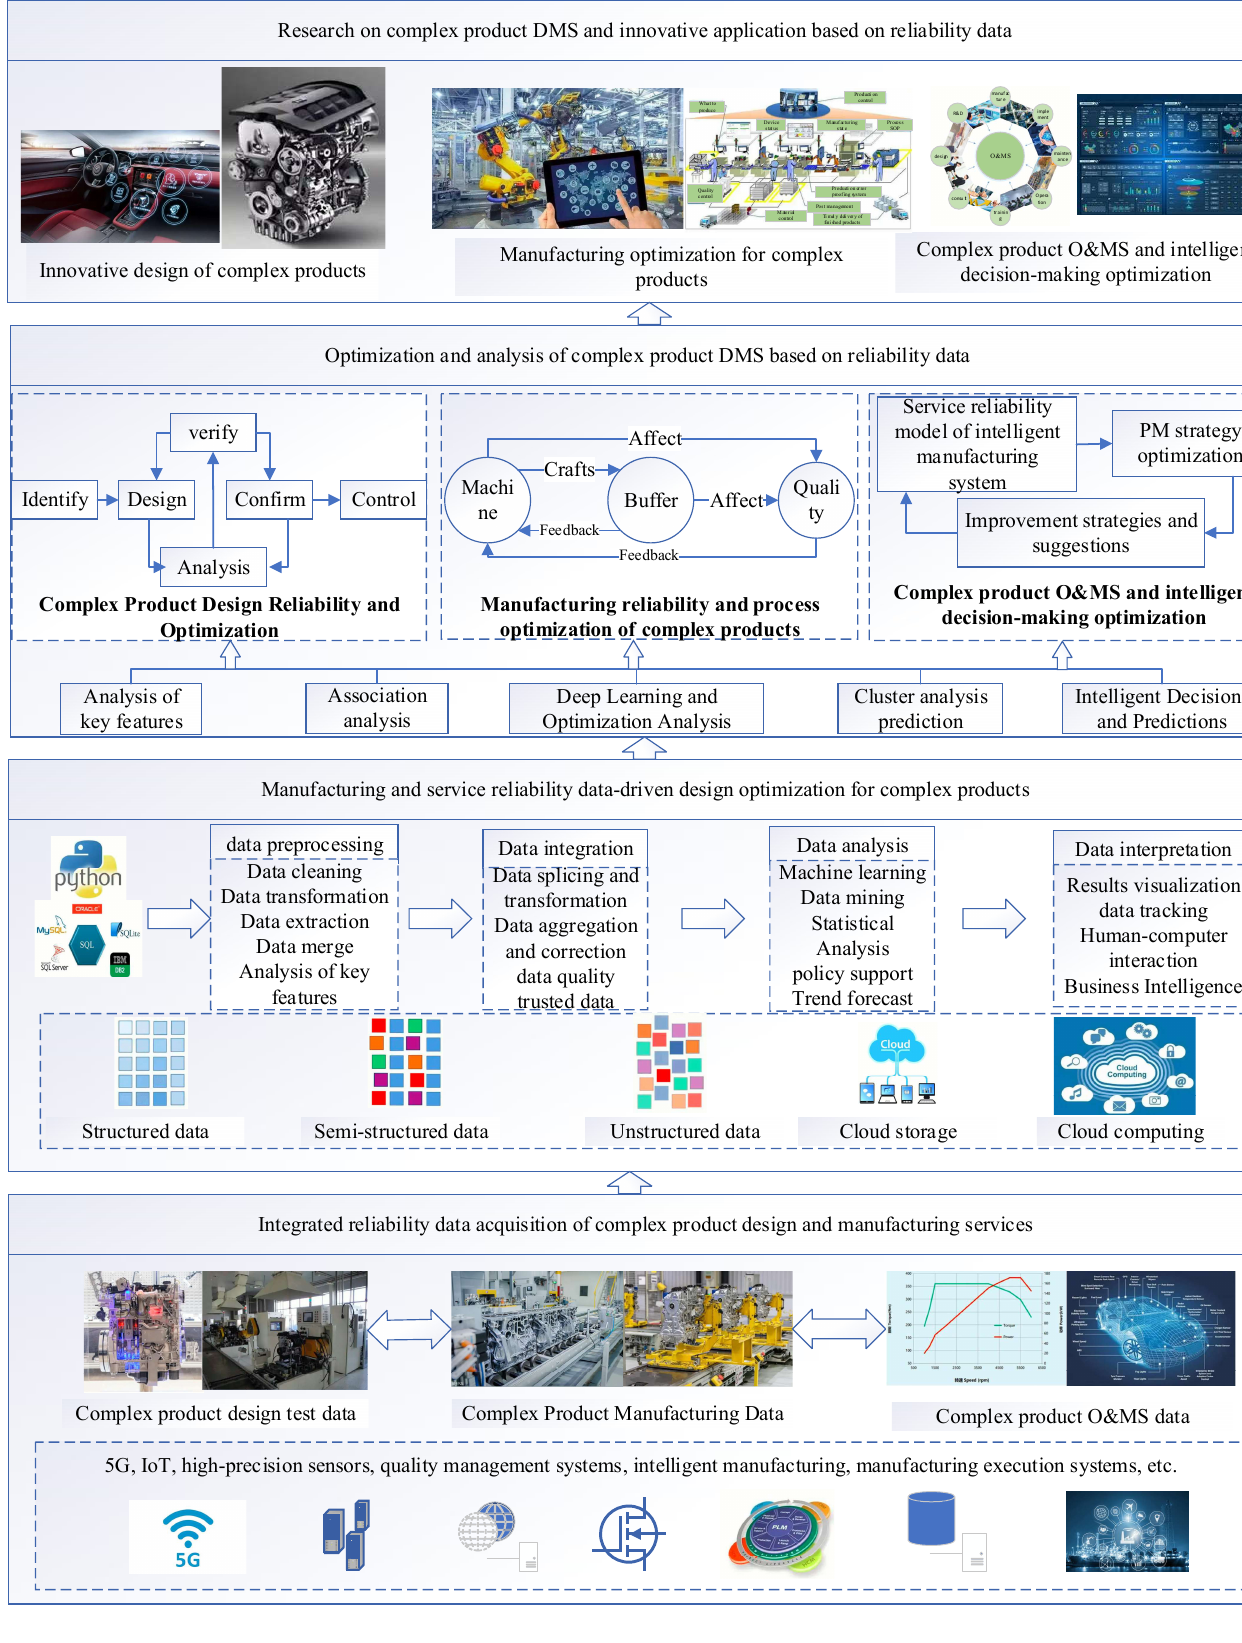
Figure 1. An integrated framework of complex product DMS.